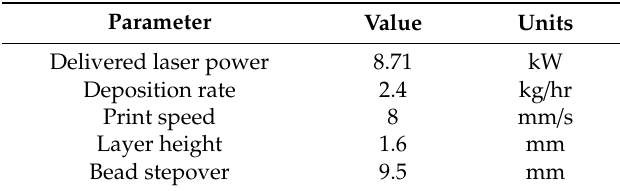
Table 1. Primary process parameters.